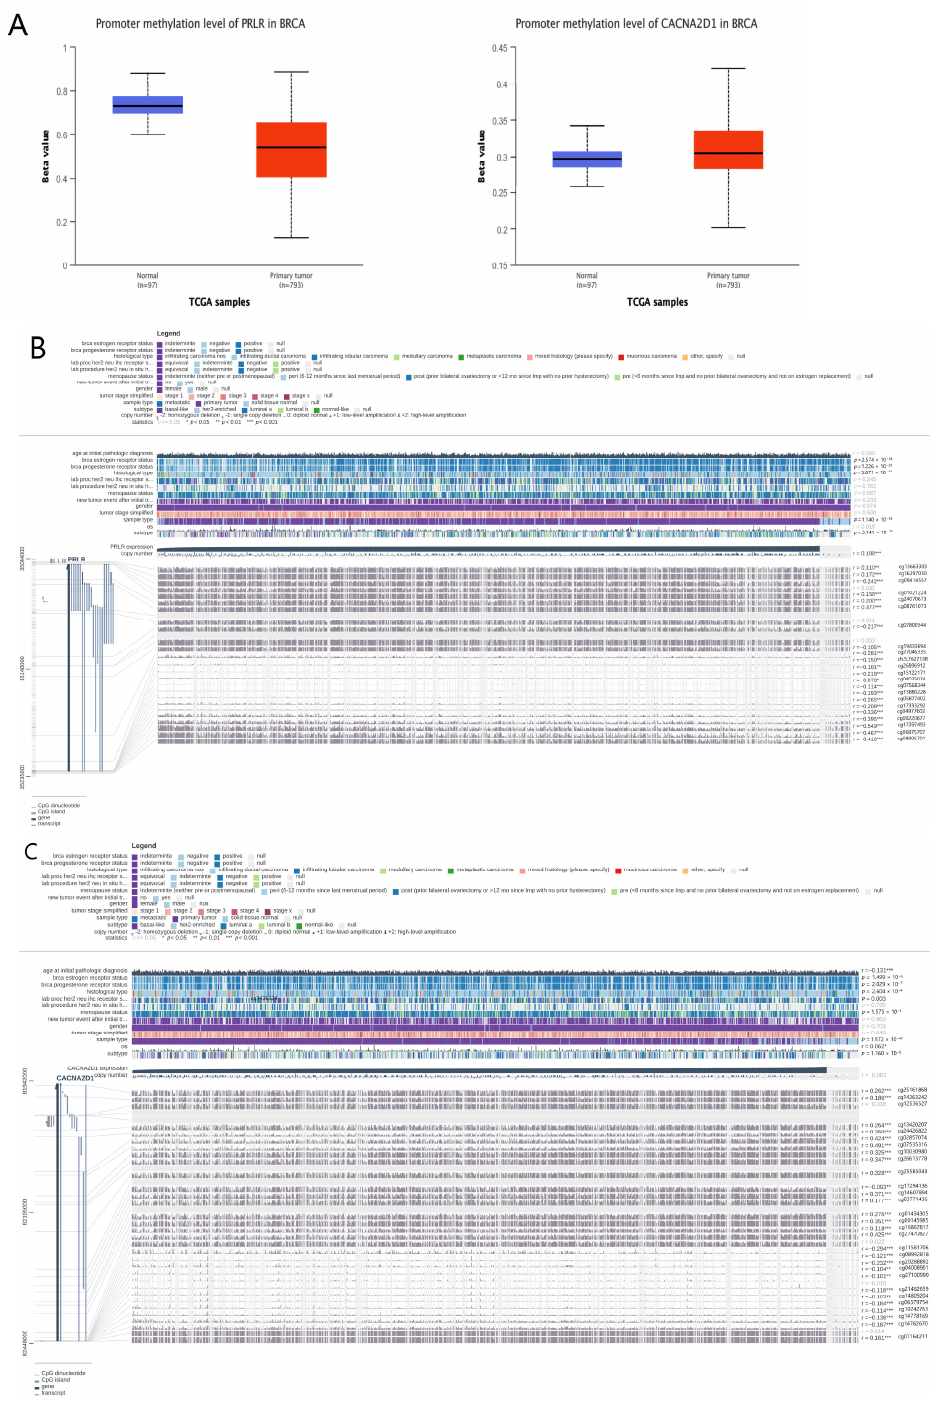
Figure 8. Methylation analysis of CACNA2D1: ( A ) Methylation of CACNA2D1 in BRCA was evaluated by UALCAN. ( B , C ) The methylation sites of PRLR and CACNA2D1 DNA sequence association with gene expression were visualized by MEXPRESS. The expression of them was illustrated by the blue line in the center of the plot. Pearson’s correlation coefficients and p values for methylation sites and query gene expression are shown on the right side.